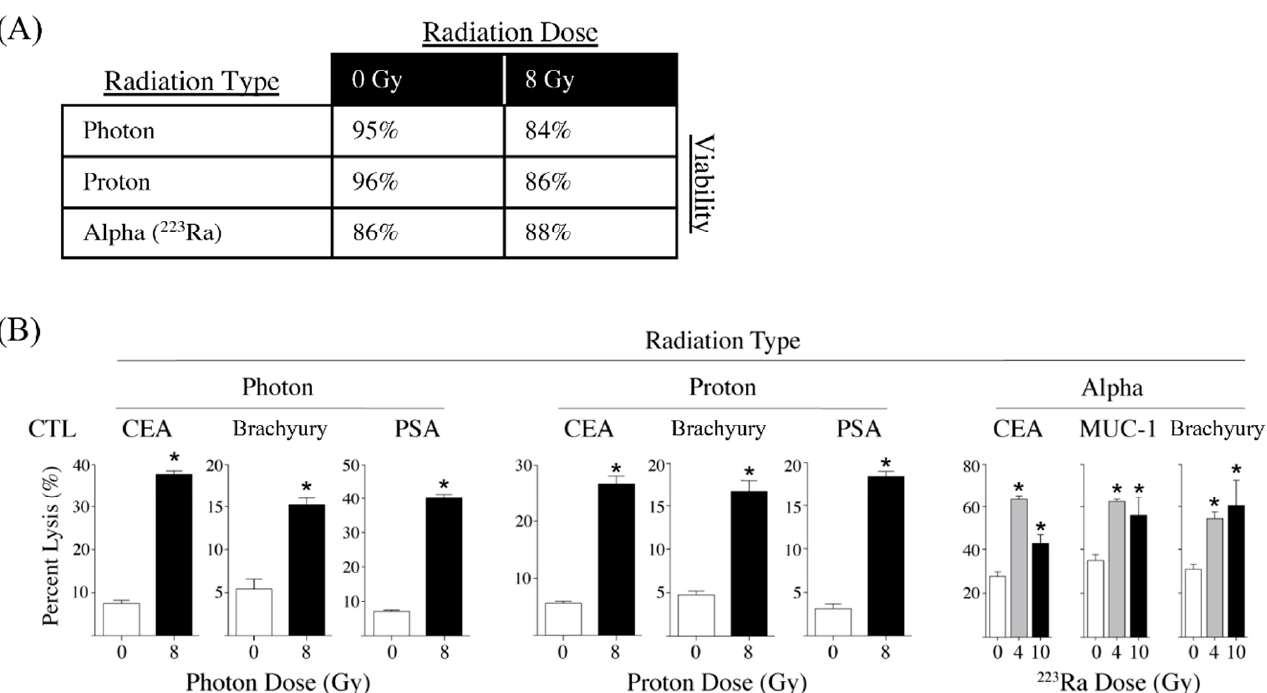
Figure 2. Sublethal exposure to photon, proton, or alpha radiation increases CTL lysis of prostate carcinoma cells in vitro. ( A ) Sublethal exposure of LNCaP prostate tumor cells in vitro to photon, proton radiation, or alpha radiation (223Ra) has minimal effect on cell viability. Human prostate carcinoma cells were mock-irradiated (0 Gy) or treated with either 8 Gy of photon radiation, 8 Gy proton radiation, or 8 Gy of 223Ra. Radiation-treated cells were cultured for an additional 72–96 h, and viability was determined by AO/PI viability dye. Depicted is % viable cells. ( B ) Human LNCaP prostate carcinoma cells were mock-irradiated (0 Gy, open bars) or treated with either 8 Gy of photon radiation (closed bars), 8 Gy proton radiation (closed bars), 4 Gy of of 223Ra (gray bars), or 10 Gy of 223Ra (closed bars). Radiation treated cells were cultured for an additional 72–96 h and then used as targets in an overnight CTL lysis assay. CEA-, MUC-1-, and brachyury-specific CD8+ T cells were used as effectors at an E:T ratio of 30:1. Experiments were repeated 1–3 times with similar results. * = p < 0.05. Adapted from